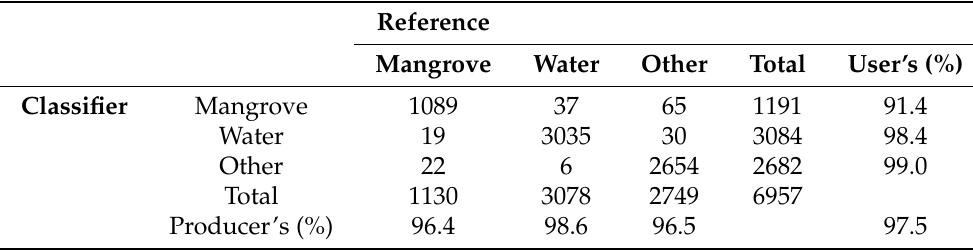
Figure 8. Example classification of mangroves in North Kalimantan, Borneo. Left: false colour Landsat 5 image from September 2009 where Red = NIR, Green = SWIR1, and Blue = Red. Right: classification of mangroves showing overestima- tion of mangroves by the COLD classifier. Mangroves in this region are spectrally difficult to distinguish from other tropical vegetation such as the mangrove palm. There is also some confusion between mangroves and aquaculture ponds. Table 7. Results of spatiotemporal accuracy assessment for the Matang Forest Reserve,